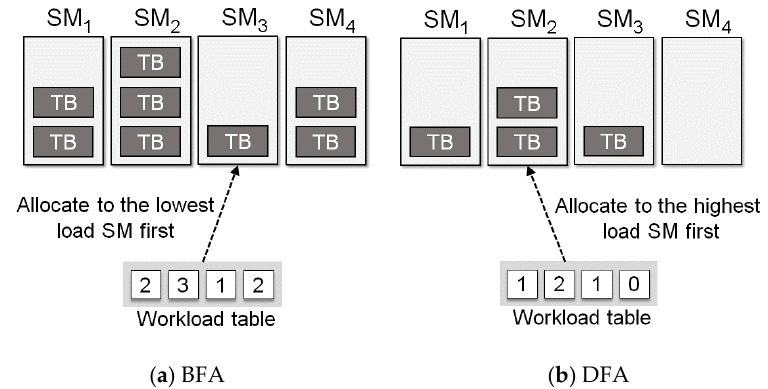
Figure 4. Comparison of the thread block allocation between (a) Breadth First Allocation (BFA) and (b) Depth First Allocation (DFA).